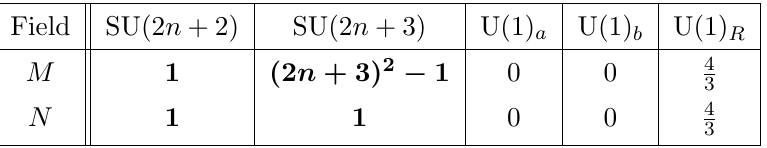
Table 4 . The charges of the (cid:13)ip (cid:12)elds under the global